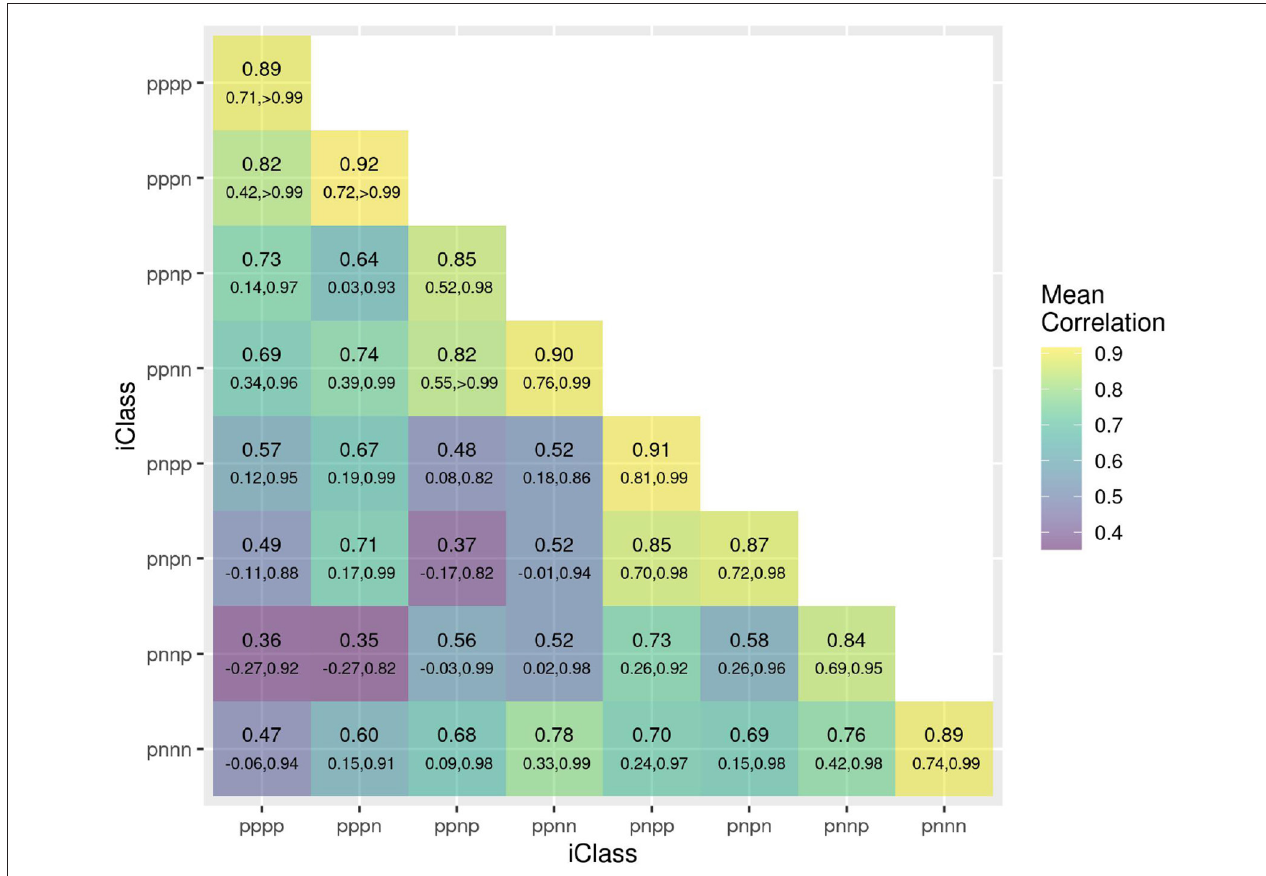
FIGURE 2 | Estimated genetic correlations for CVE effects for all pairs of environments summarized on an iClass basis. The value listed uppermost in each cell is the mean of all pairwise estimated correlations between environments in the iClass; the values underneath are the minimum and maximum correlations between environments in the iClass. The color scale corresponds to the mean